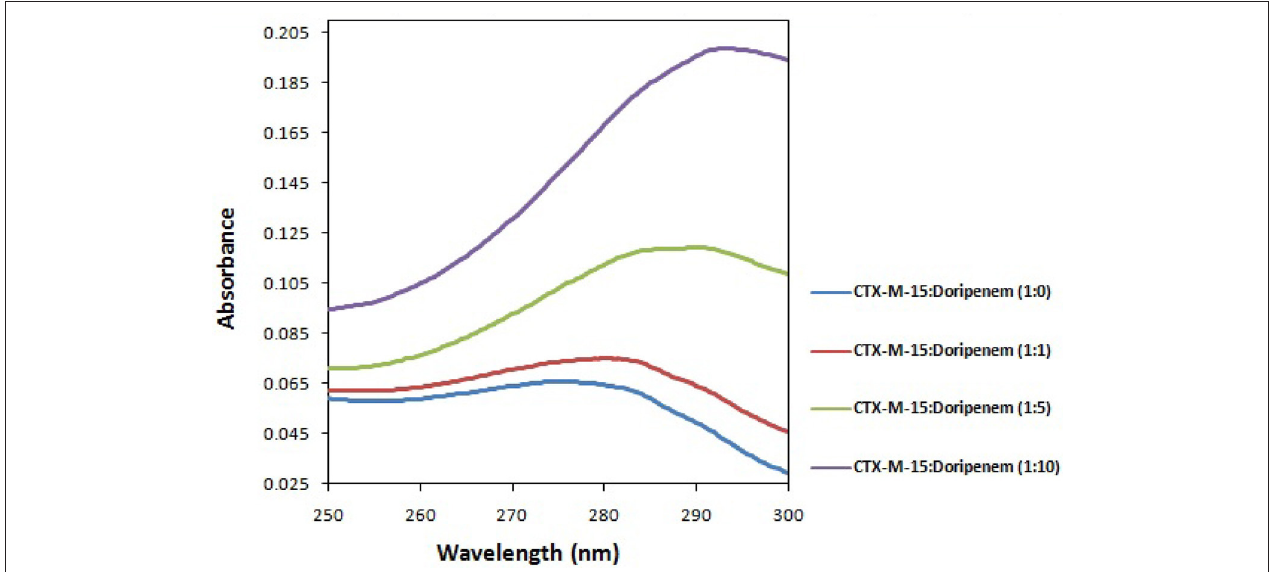
FIGURE 1 | UV absorption spectra of CTX-M-15 (2 µ M) between 250 and 300 nm wavelength range in the absence and presence of 2, 10, and 20 µ M of doripenem. The spectra was taken at 298K in 50 mM sodium phosphate buffer of pH